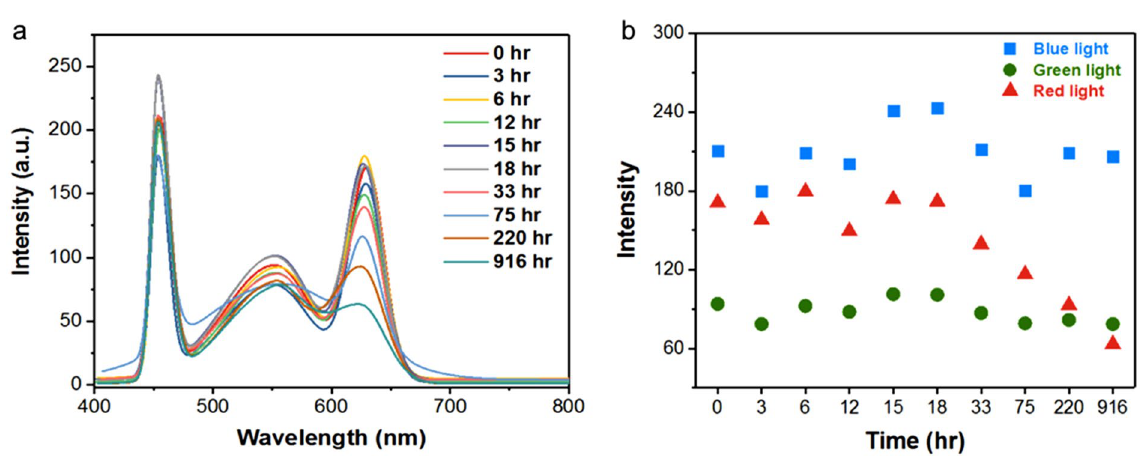
Figure 3. ( a ) Overall packaged LED’s luminescence data. ( b ) The variations of maximum emission intensity of blue, green and red